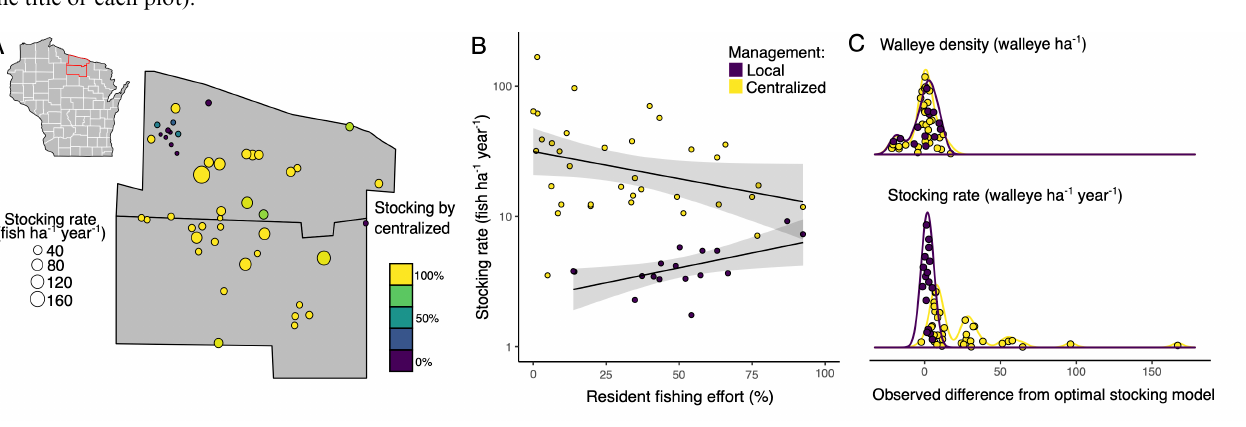
Fig. 3 . (A) Observed stocking rates of walleye, and the proportion of the stocking that is conducted by centralized, rather than local, management in 46 lakes in northern Wisconsin, USA. (B) As predicted by the model, higher contributions by local resident anglers to total angling effort were positively associated with observed stocking by local managers ( p = 0.004) and negatively associated with observed stocking by the centralized manager ( p = 0.04). (C) Observed stocking rates by local management organizations were greater than, but close to, the optimal stocking rates predicted by our model (mean difference 1.9 fish ha -1 year -1 , paired t test, p < 0.001), while those by centralized management were generally much greater than predicted optima (mean difference 27 fish ha -1 year -1 , p < 0.001). Walleye densities were similar to model predicted values on average ( p = 0.8 and p = 0.7 for local and centralized management, respectively). Circles show the differences between observed and predicted values for individual lakes; these are positioned along the y-axis to help visualize the kernel density estimates of the frequency distributions, which are shown with lines. The two plots share the same x-axis scale (indicated along bottom of the bottom plot) but have different x-axis units (indicated in the title of each